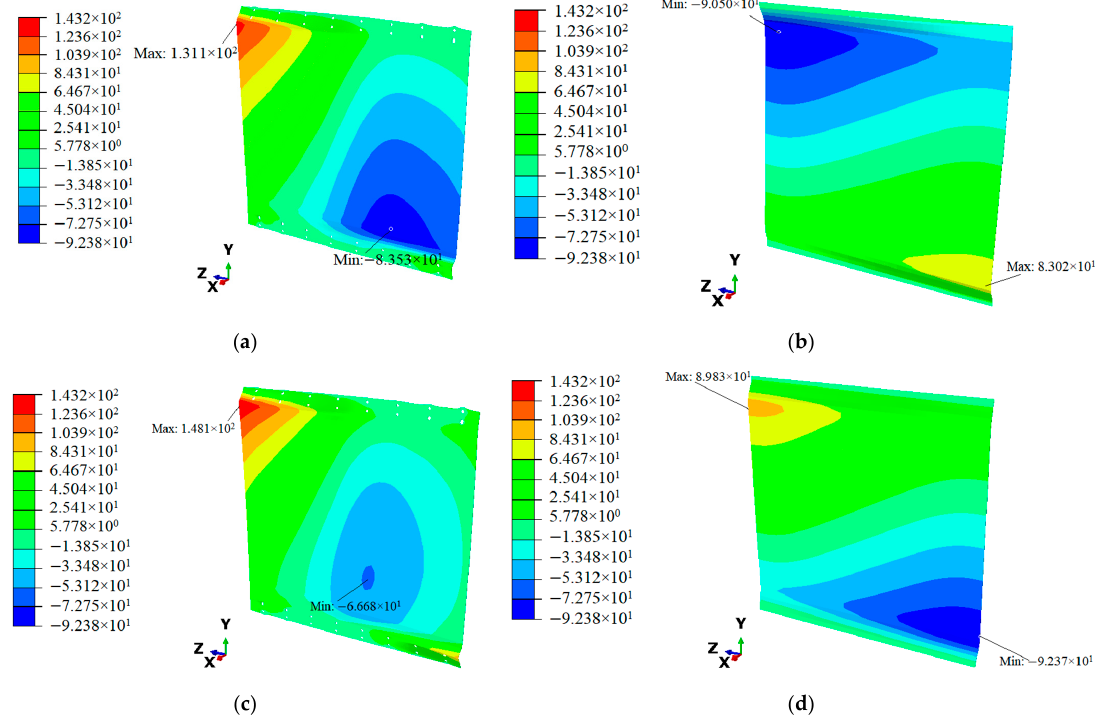
Figure 16. Out-of-plane deformation cloud of partial models at the drift ratio of 0.02 under cyclic loading (unit: mm): ( a ) SPSW-N8; ( b ) SPSW-T; ( c ) SPSW-N8-X; ( d ) SPSW-T-X.